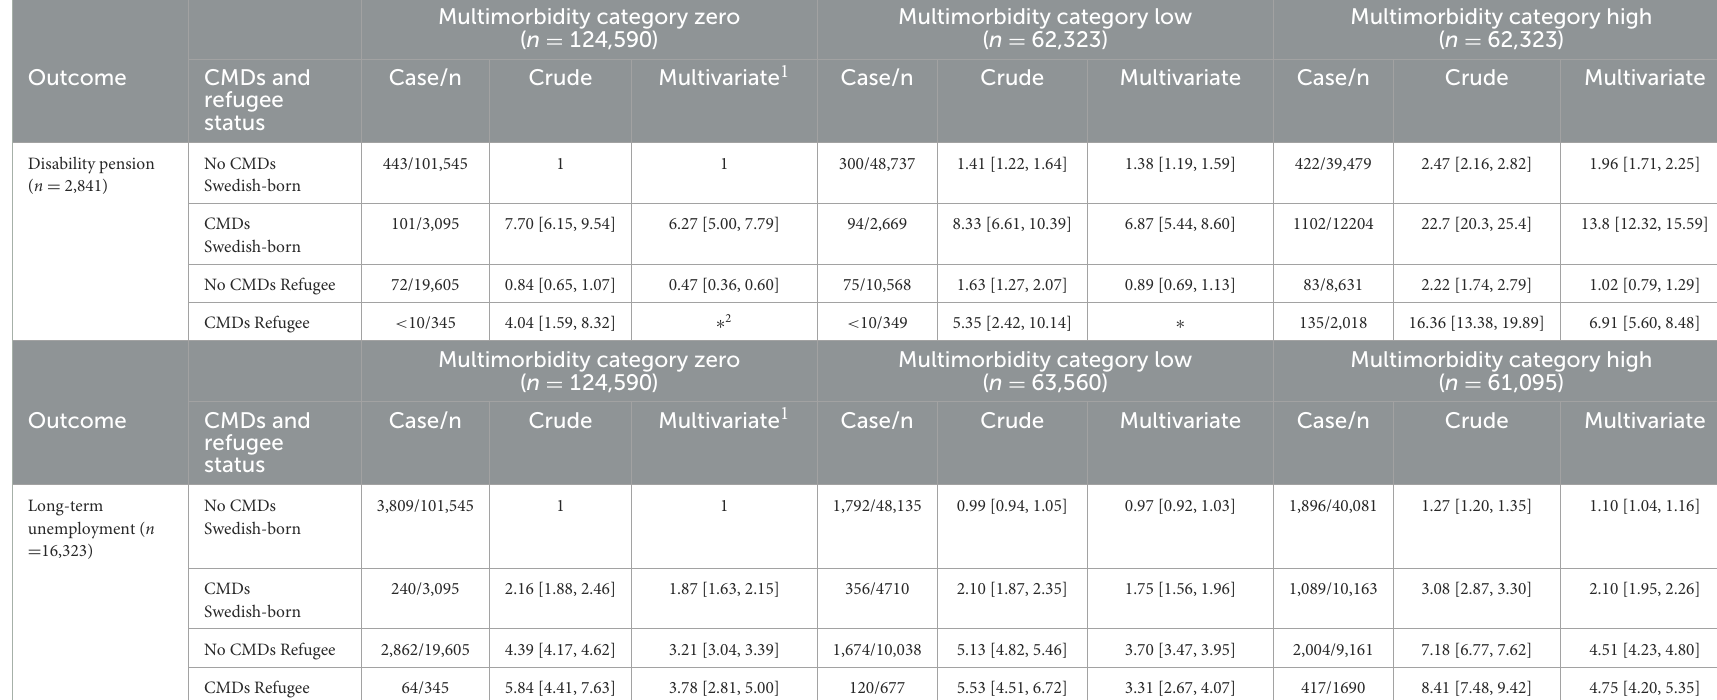
TABLE 2 Odds ratios (95% Confidence Intervals) regarding subsequent disability pension and long-term unemployment (2012–2016) according to three multimorbidity categories, stratified by refugee status and common mental disorders (CMDs) in 249,245 young adults in